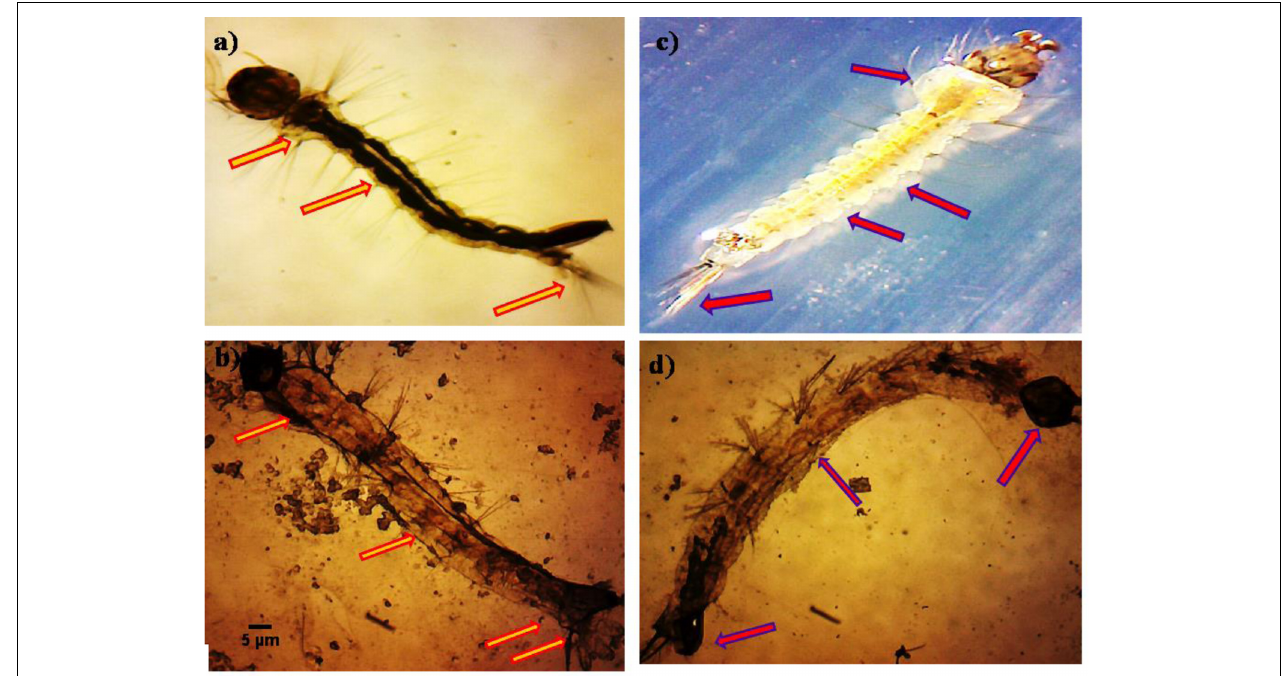
FIGURE 3 | Stereo microscopic study of third instar (a,c) control larvae of Aedes aegypti and Culex quinquefasciatus of midgut, thorax, and anal gill parts. (b,d) Ae. aegypti and Cx. quinquefasciatus treated with P. daleae mycelium extract at 1000 µ g/ml concentration and extract treatment induced toxic effects on many regions of the body including thorax, abdomen, anal gills, (red and violet arrows) indicates loss of external hairs, crumbled epithelial layer of the outer cuticle and shrinkage of the larvae, respectively.